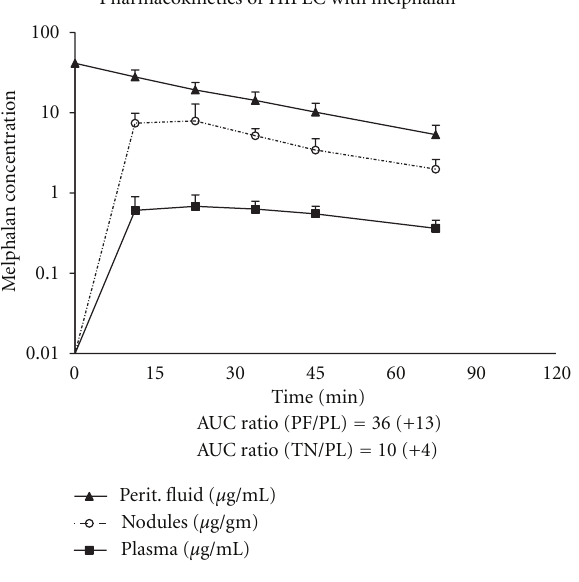
Figure 3: Pharmacologic analysis showing peritoneal fluid, plasma, and tumor nodule levels of melphalan in 20 patients treated with cytoreductive surgery and HIPEC with melphalan.